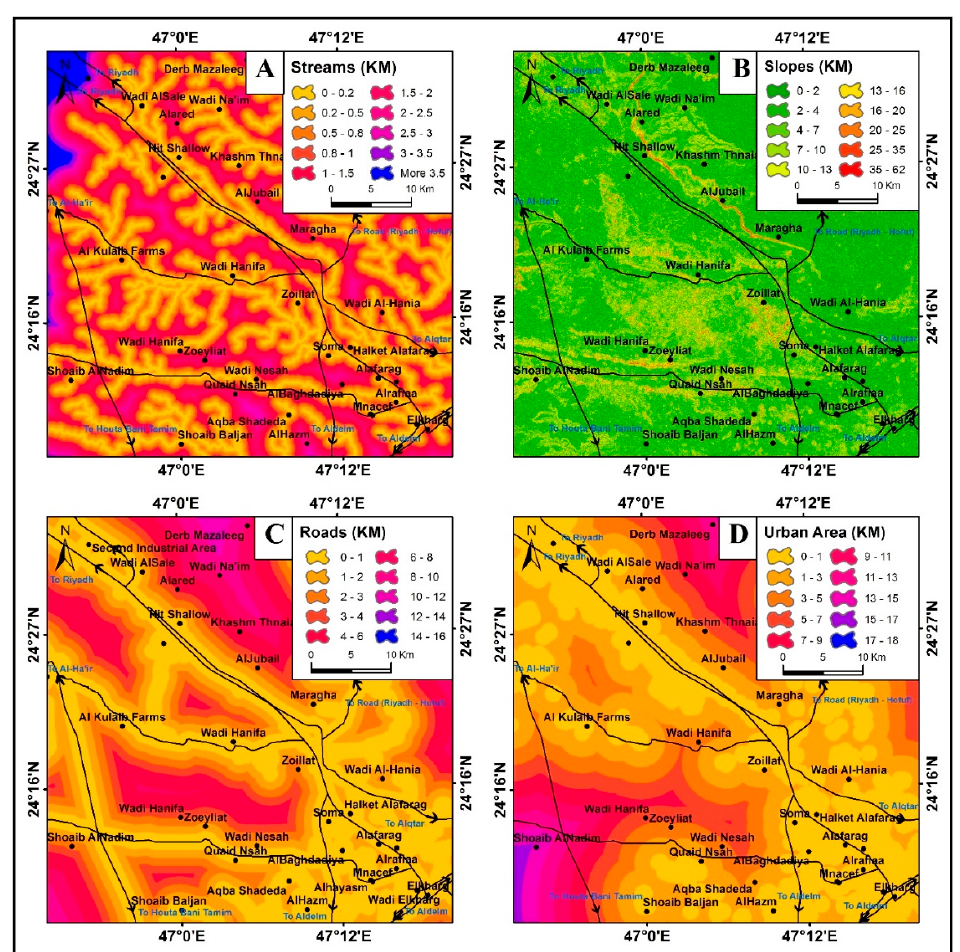
Figure 6. The distance ranges (part 1): ( A ) streams / valleys, ( B ) earth surface slopes, ( C ) road networks, ( D ) urban areas.